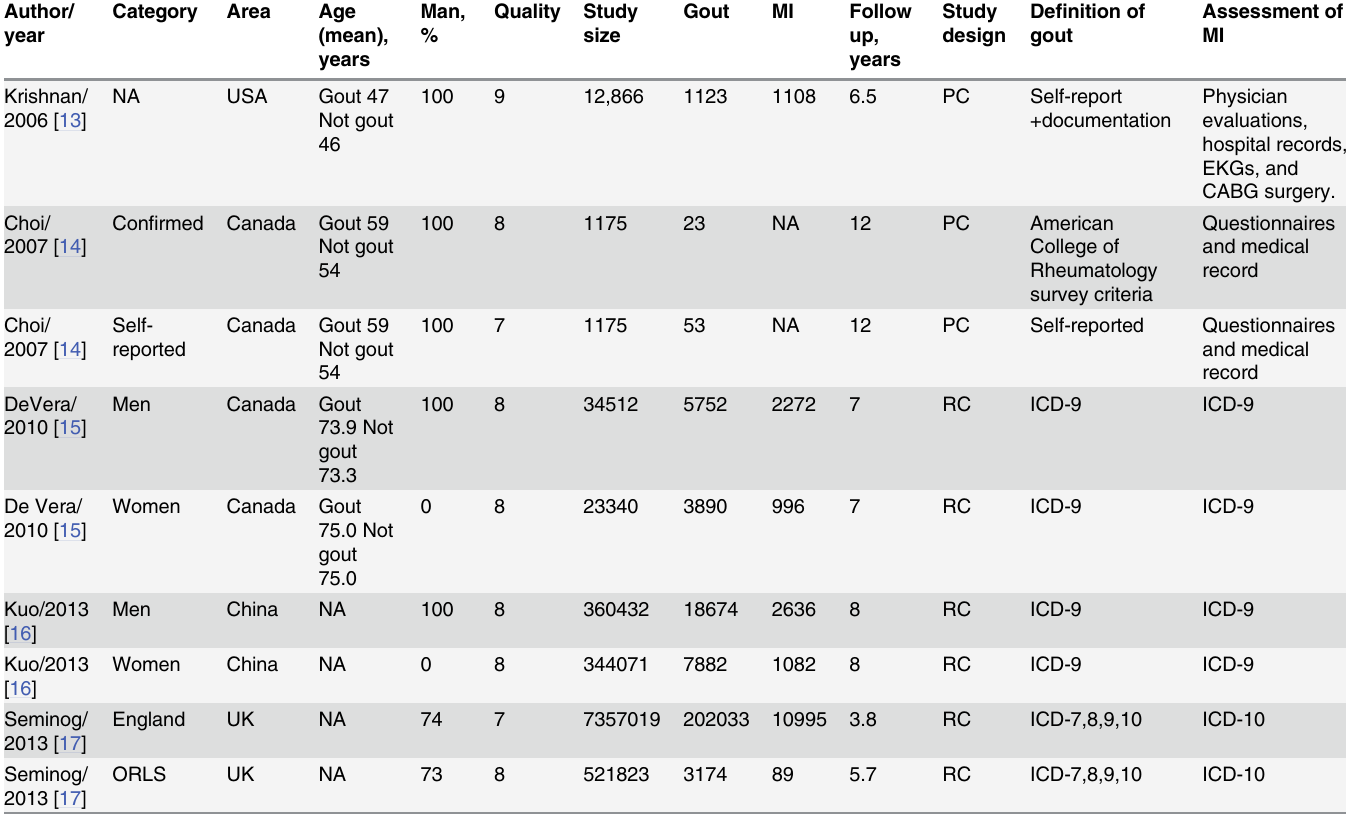
Table 1. Main characteristics of cohort studies included in the meta-analysis. MI: myocardial infarction, AMI: acute myocardial infarction, PC: prospec- tive cohort, RC: retrospective cohort, NA: not available, CABG: coronary artery bypass graft, ECG: